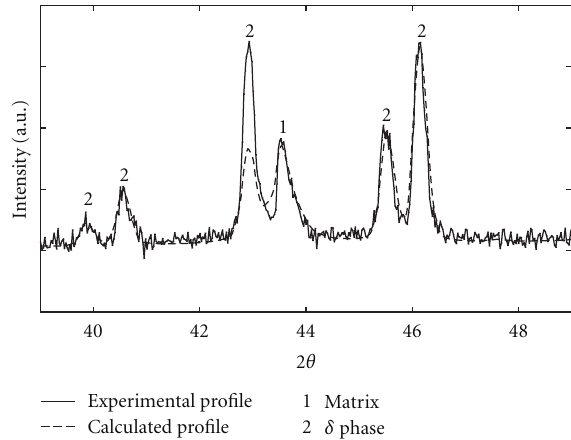
Figure 2: Whole experimental X-ray diagram with first indexation of the lines, showing that all the peaks may be attributed to either the fcc matrix or the delta phase.